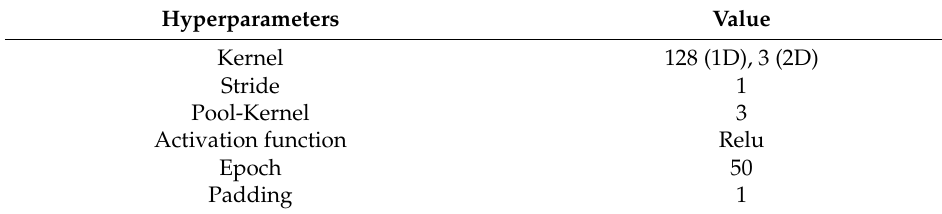
Table 1. Hyperparameters of CNN.